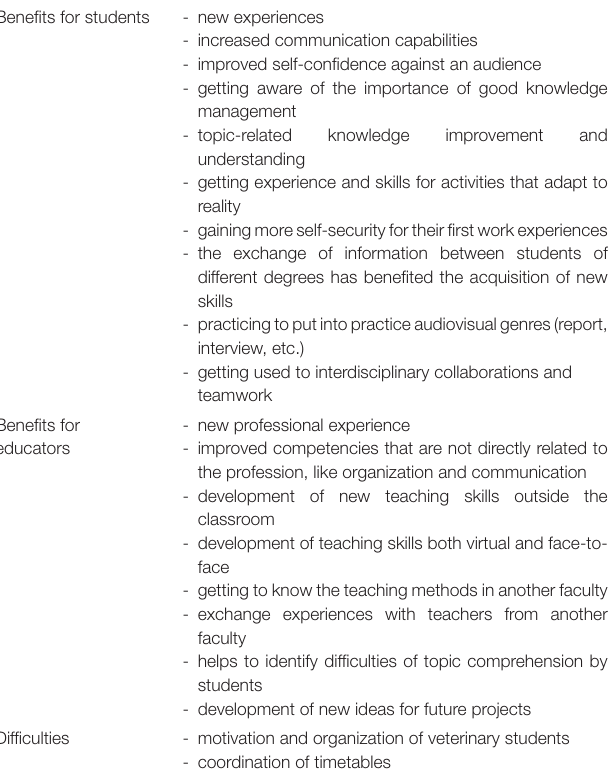
TABLE 1 | Benefits and difficulties identified by the professors participating in the study. Benefits for